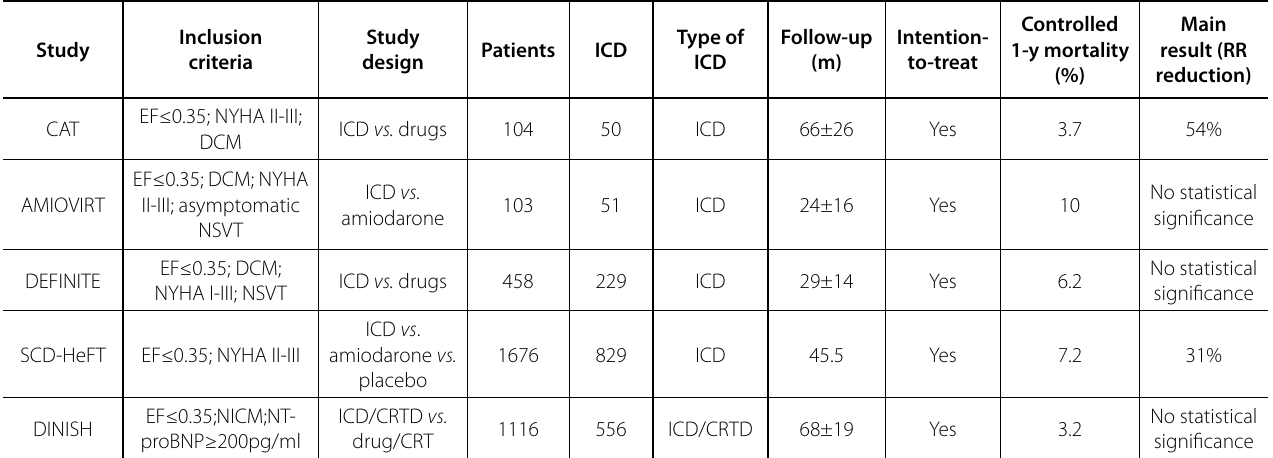
Table 1. Main features of included articles.